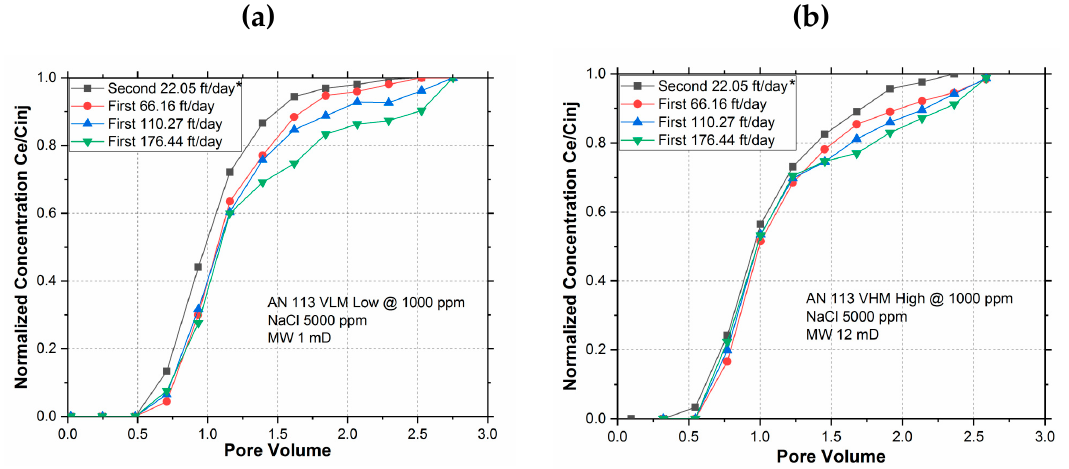
Figure 3. Retention behavior at 1000 ppm of polymer with 5000 ppm NaCl salinity.